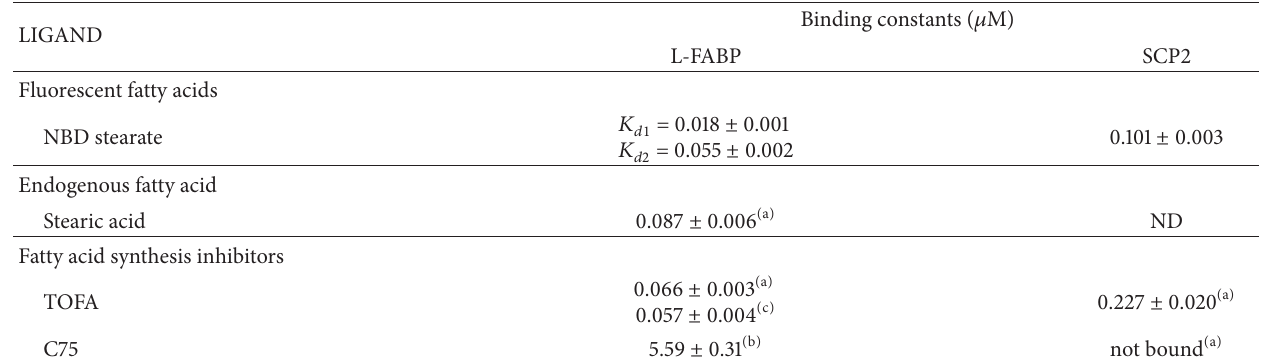
Table 1: Binding constants of fatty acids, TOFA, and C75 to L-FABP and SCP-2.